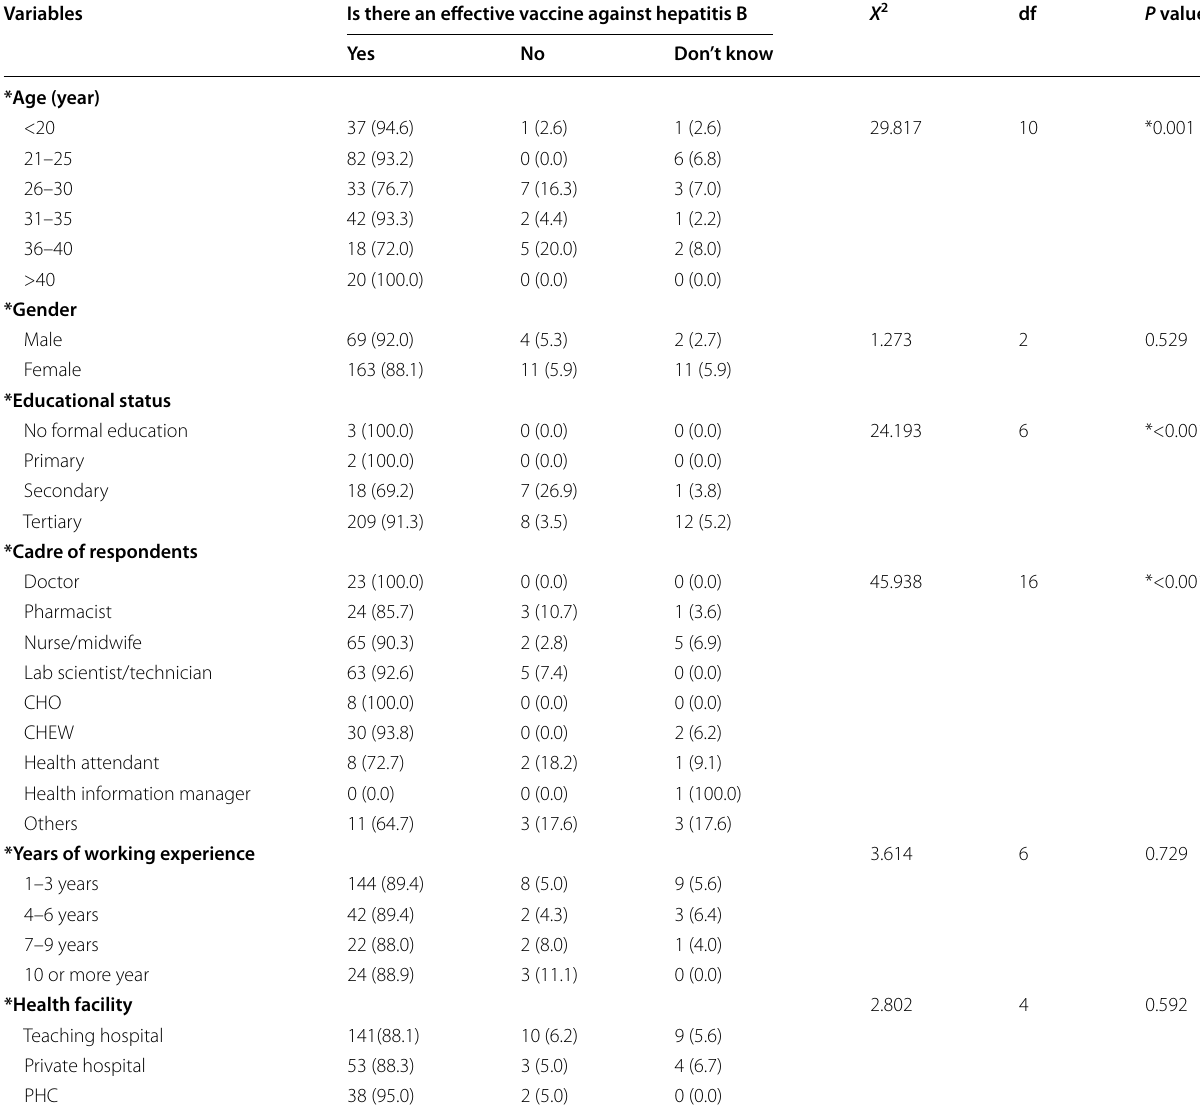
Table 4 Association between respondents’ socio-demographic characteristics and the knowledge of an effective vaccine against hepatitis